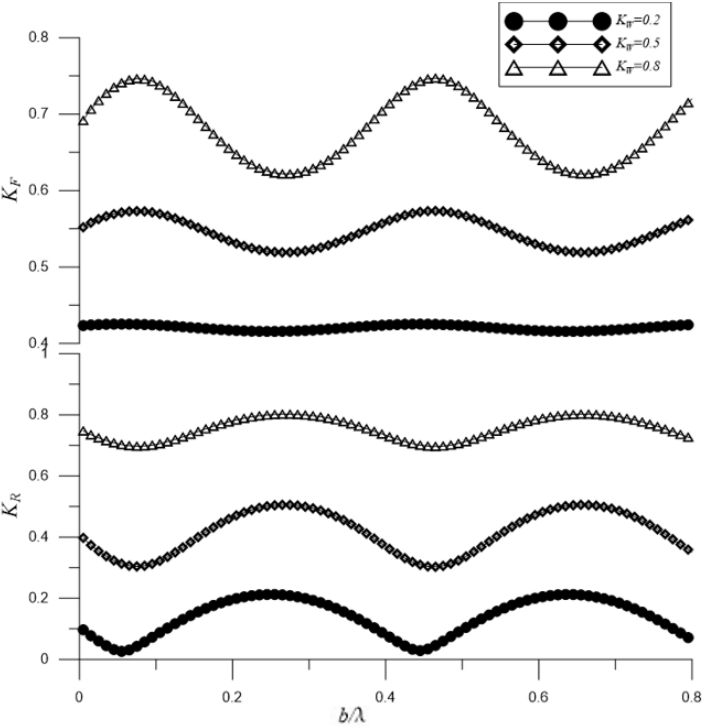
Figure 12. Effects of the wall partially reflecting factors K w on the dimensionless wave force and reflection coefficient with normal incidence.